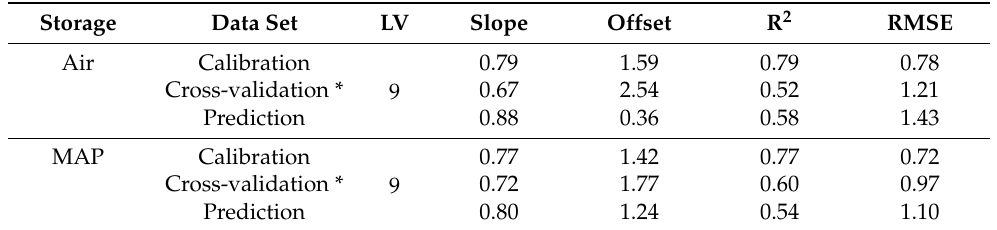
Table 3. Performance metrics of the PLS-R models developed on MSI data for the estimation of TVC in gilthead sea bream fillet samples.